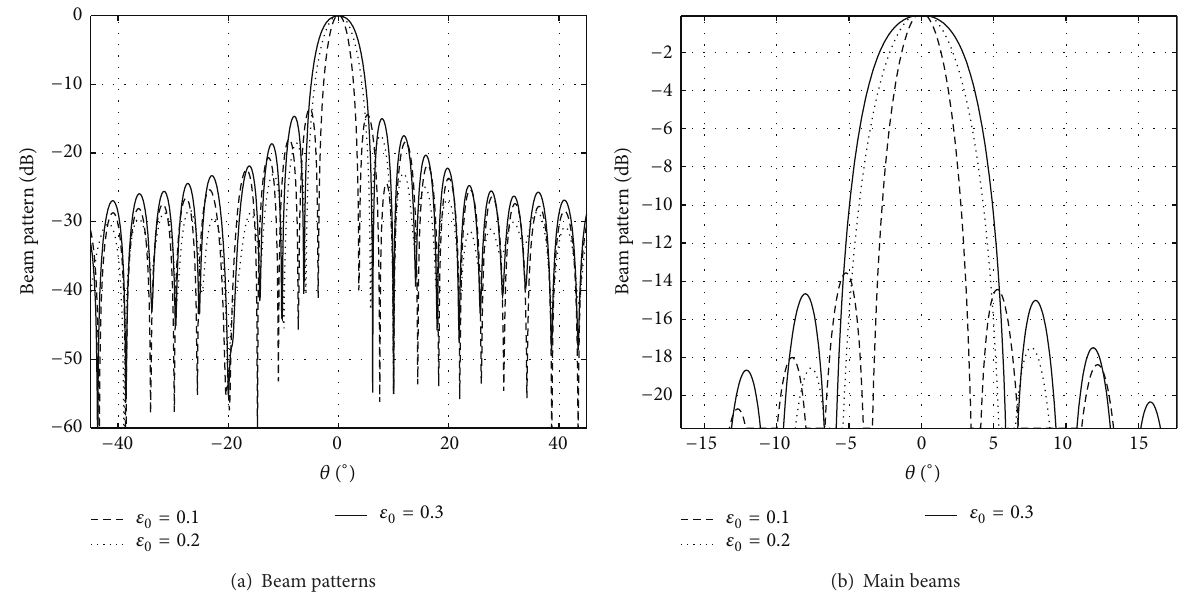
Figure 1: Various beamformers’ beam patterns with 20 × 𝑁